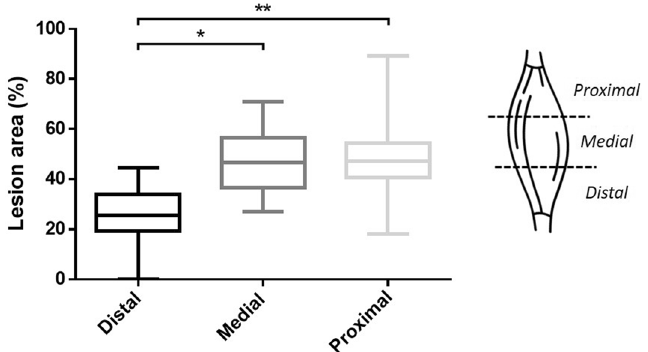
Muscle damages were then evaluated in TA proximal and medial parts by focusing on the injected area (β-gal + region). At 1- and 3-days after injection, a slight thickening of the extracellular matrix and a straight mark with some mononuclear cells and regenerating fibres (probably corresponding to the injection site) were observed. This led to a global ‘lesion’ percentage defined by HEB staining of 16.3% and 12.9% at 1- and 3-days post- injection, respectively. At 7 days after electroporation, extensive injuries, a marked inflammatory infiltrate and an extracellular matrix expansion were detected. At this time point, damaged surface area represented 47.2% of the injected area (Fig. 5, median value, p < 0.05 7-days vs 1- and 3-days). Expression of DUX4 and its target genes in hIMEP mice. DUX4 expression at the mRNA level was investigated by 3 ′ RACE in hIMEP treated mice. In addition, mRNA levels of two DUX4 target genes ( Wfdc3,